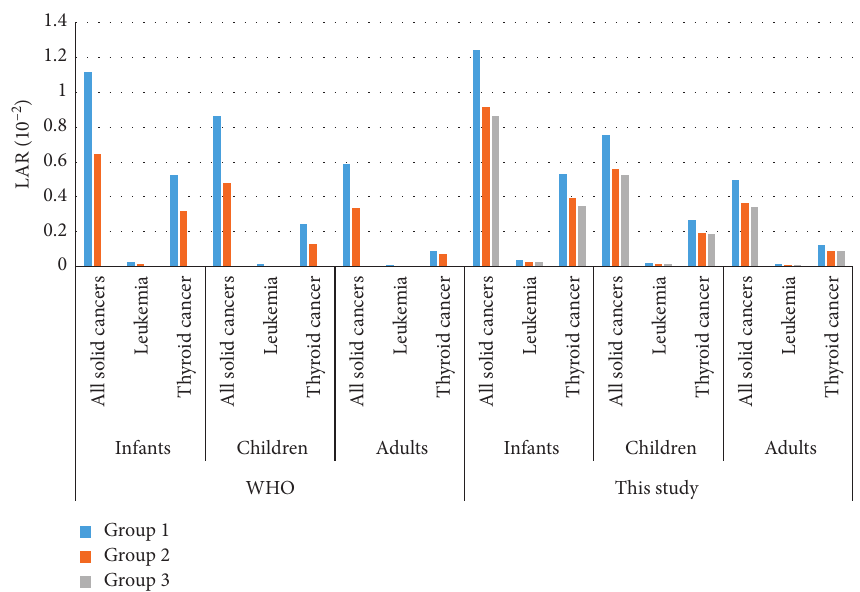
Figure 2: Comparison of LAR for cancer sites of females between WHO and this